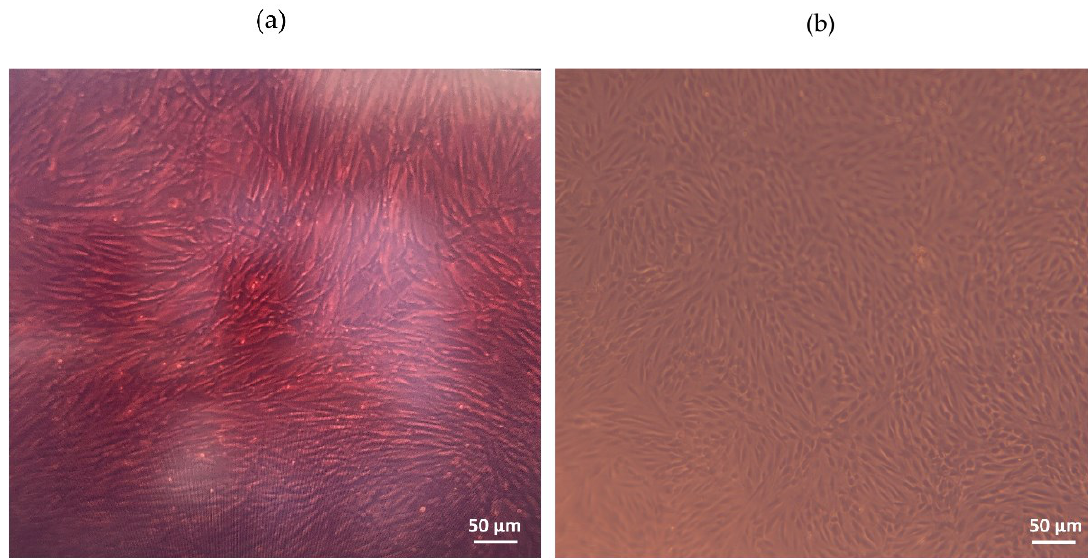
Figure 6. Images of cell monolayers cultured on the CellDrum PDMS membrane under phase-contrast microscope ( a ) Human arterial smooth muscle cells (haSMC), and ( b ) Human Dermal Fibroblasts-Adult (nHDFa).